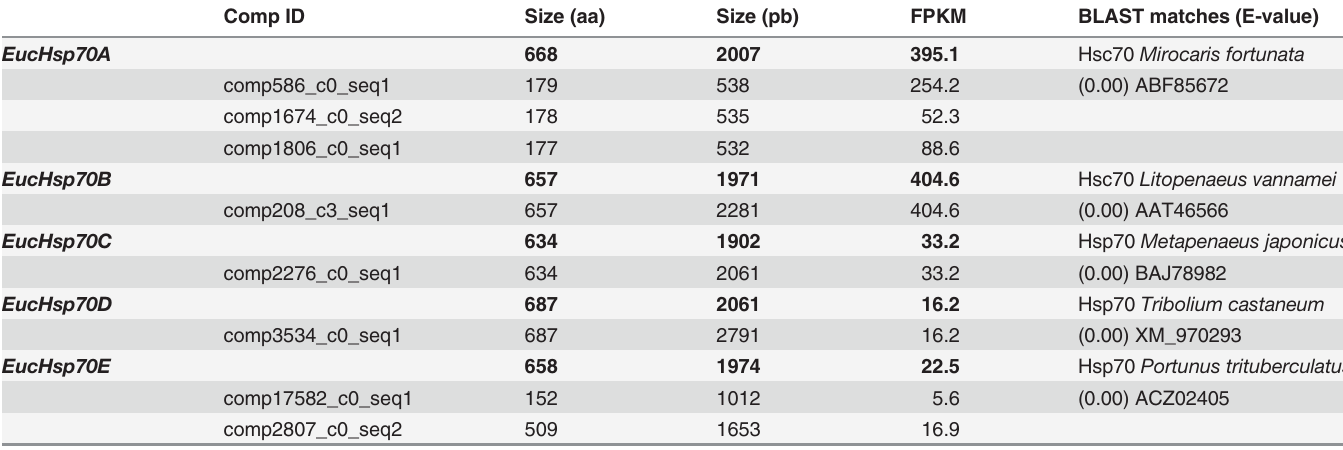
Table 3. E . crystallorophias Hsp70 isoform expression values and associated Blast